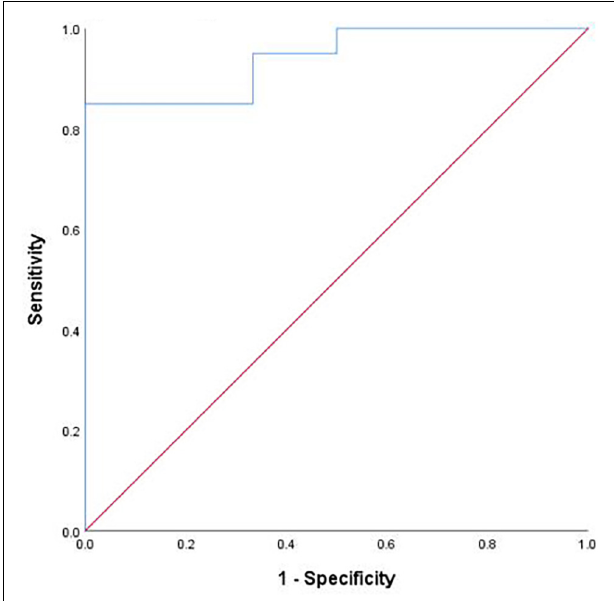
FIGURE 2 | Regression classification accuracy. Note : Receiver operating characteristic curve demonstrating the classification accuracy (predicted probability of improved vs not improved quality of life) of the logistic regression. The diagonal dashed line represents chance classification